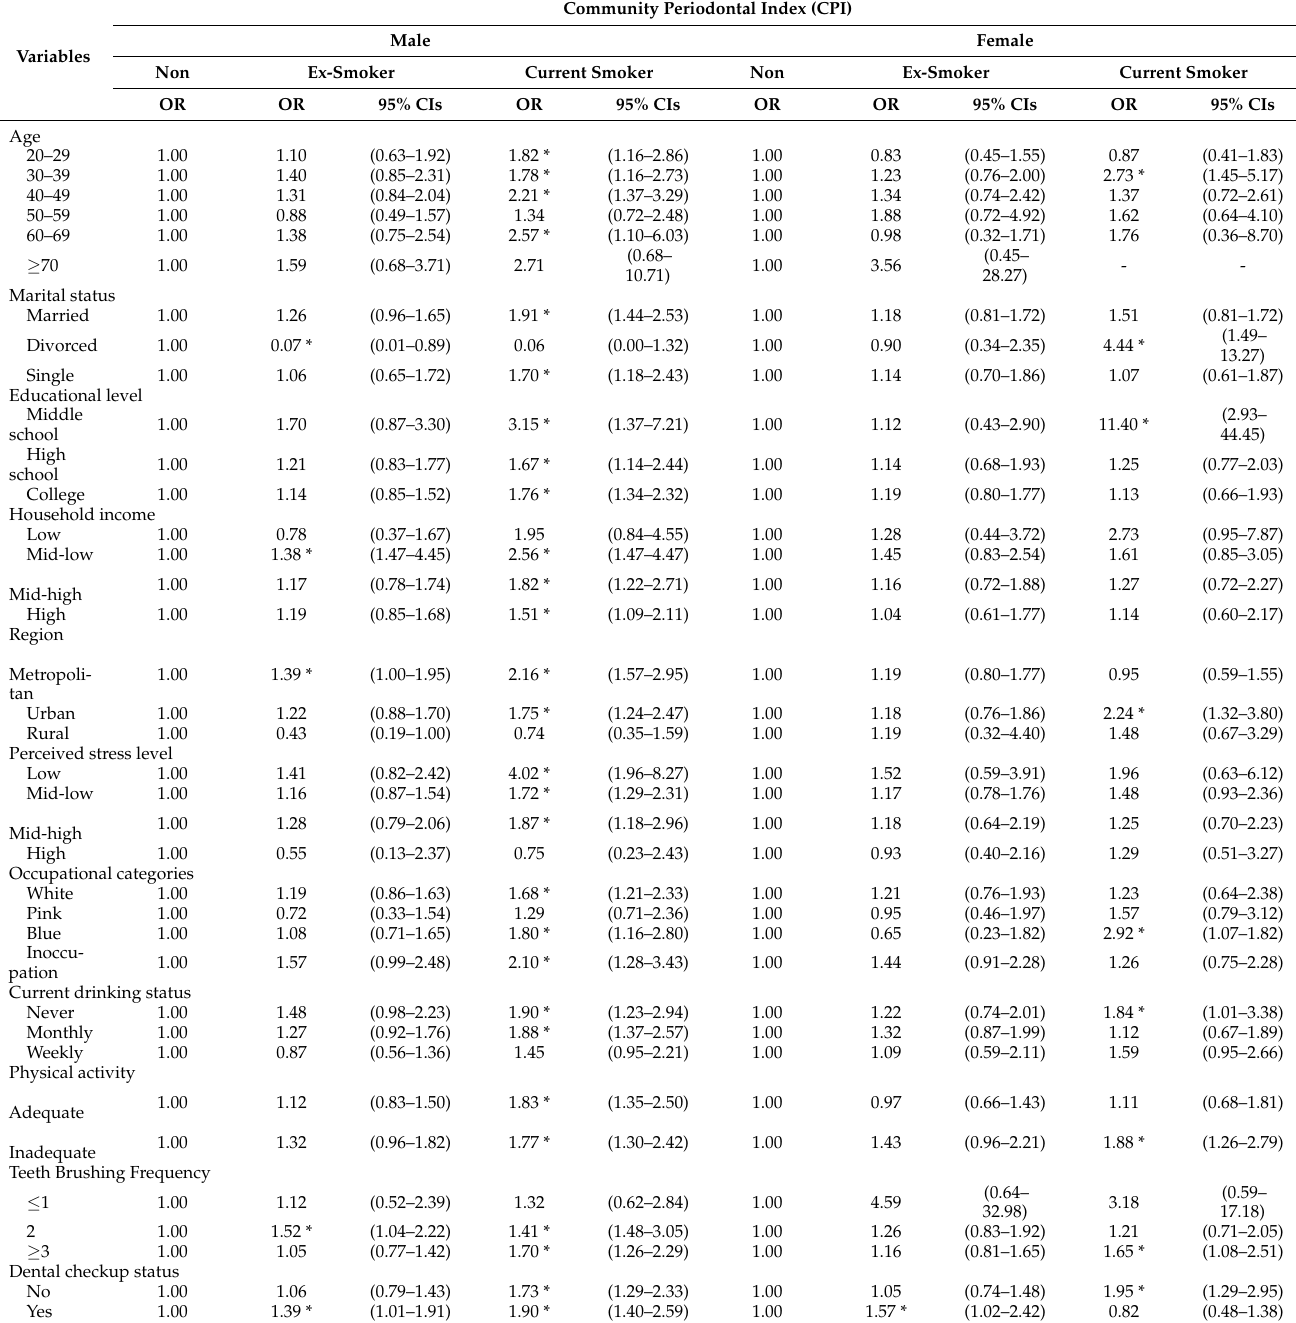
Table 3. Results of subgroup analysis stratified by independent